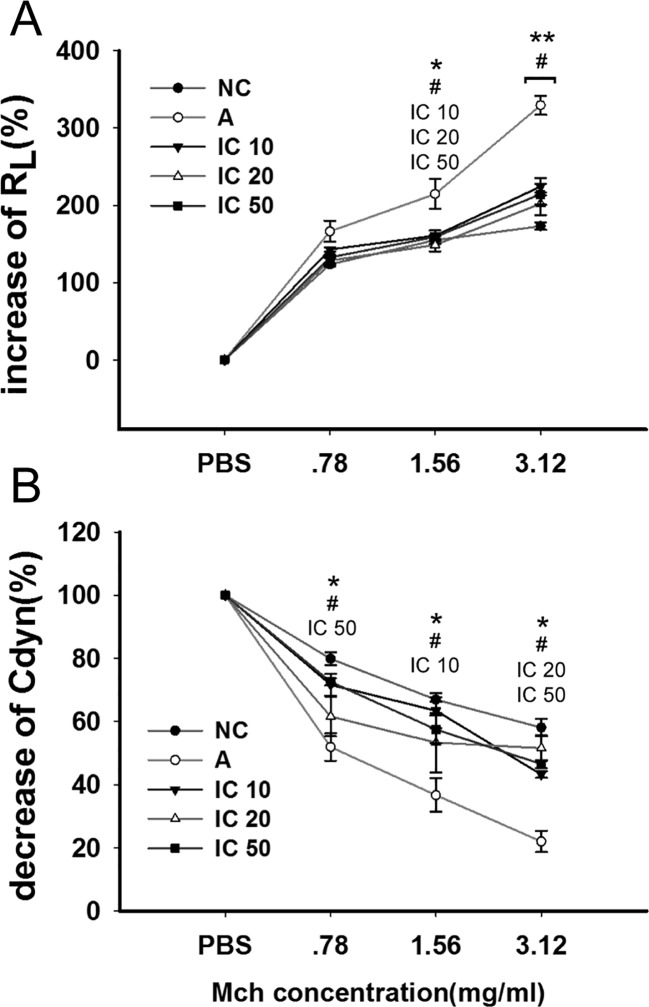
 Icariin decreased airway hyperresponsiveness (AHR) to elevating doses of methacholine (Mch) by decreasing airway resistance (RL) and increasing dynamic compliance (Cdyn) in asthmatic rats. The diagram illustrated changes of RL (A) and Cdyn (B) among different groups. Data were expressed as percentage change from the baseline value. *p < 0.05 and **p < 0.01 vs NC group; #
p < 0.05 vs A group. IC10, IC25 and IC50 indicated treatments with icariin at 10, 25 and 50 mg/kg, respectively.